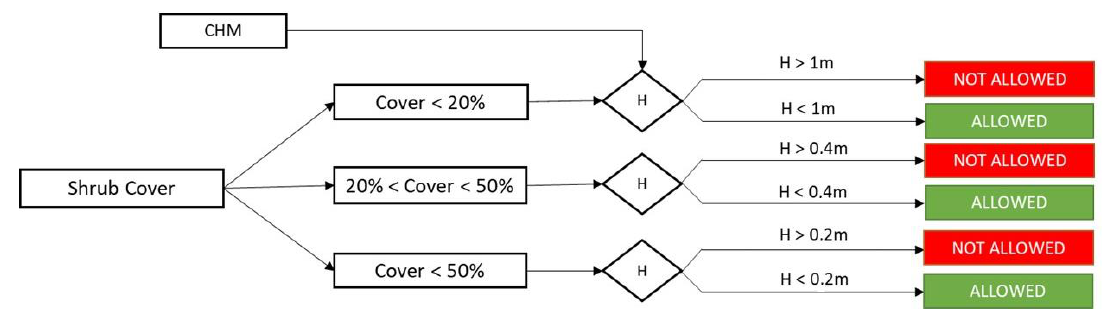
Figure 14. Decision tree, implemented to verify the degree of compliance with the condition of the 406 shrub strata. H is the total height obtained from the CHM, and cover values are obtained from the 407 shrub cover model. 408